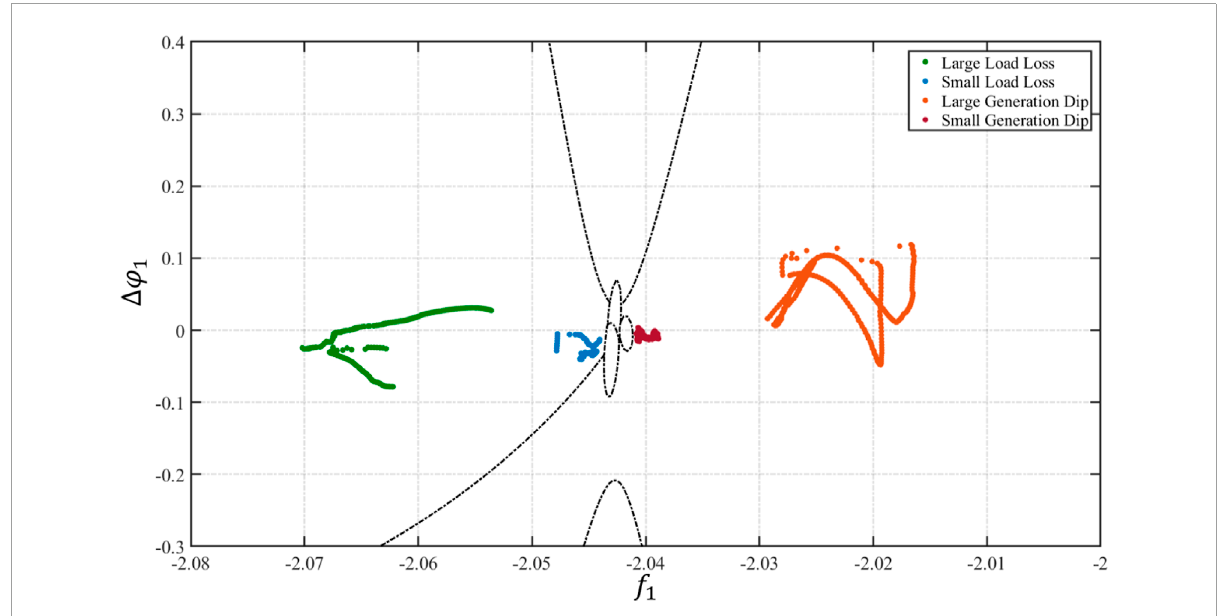
FIGURE 6 PSEC results highlighting the effect of event